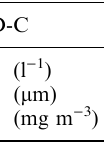
Fig. 10. a Fraction of IWC , b extinction coe(cid:129)cient (cid:114) and c e(cid:128)ective radius Re contributed by FSSP to total IWC, (cid:114) and R both FSSP and 2D-C